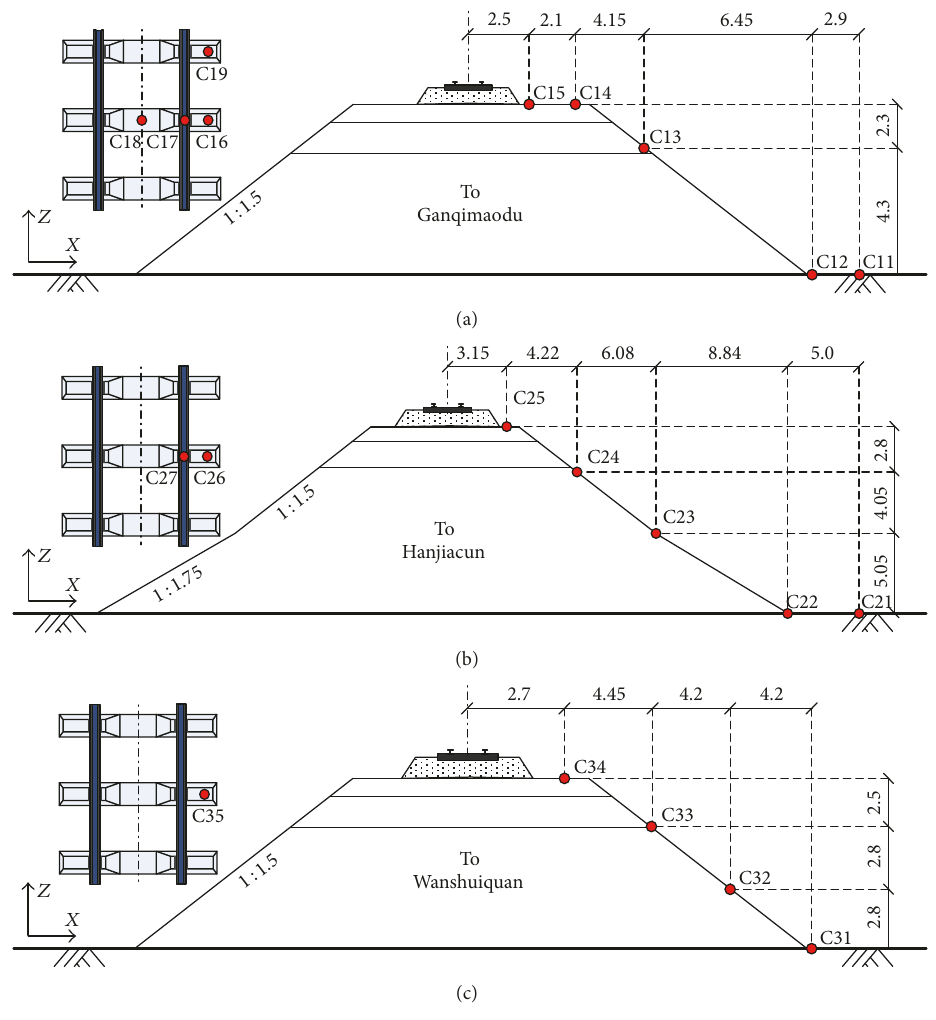
Figure 4: Accelerometer configuration: (a) site 1, (b) site 2, and (c) site 3.